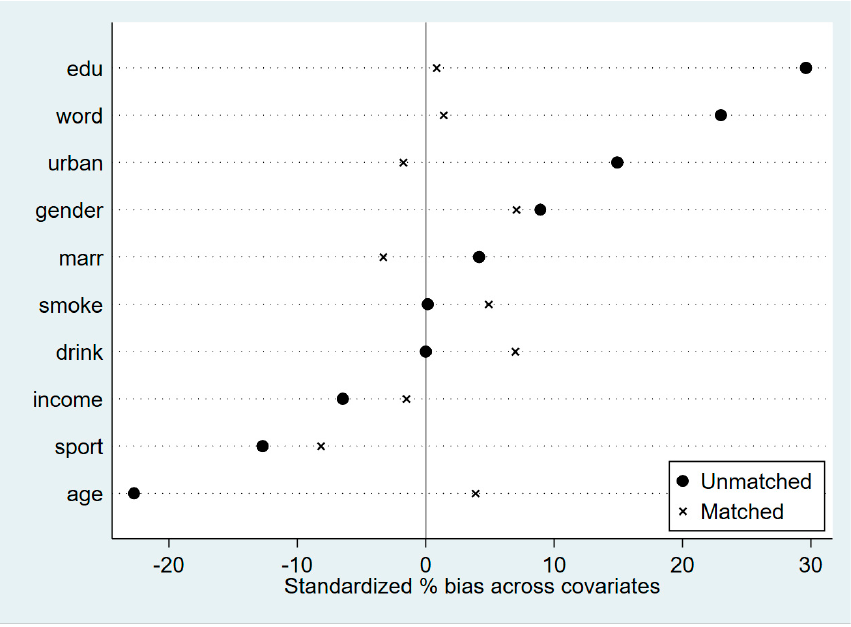
Figure 2. Standardized deviation before and after covariate matching.